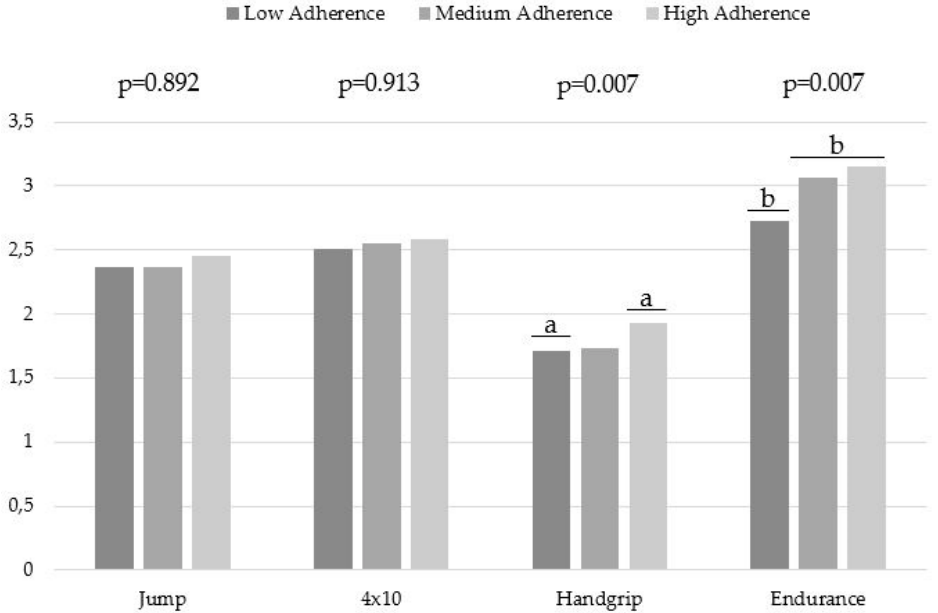
Figure 1. Alpha Fitness physical variables results based on the average levels established by Ortega et al. (2011) according to the different levels of adherence to the MD [39]. Note: Alpha Fitness Levels: 1 (very low), 2 (low), 3 (average), 4 (high), 5 (very high). a statistically significant difference between high adherence with respect to low, b statistically significant differences between medium and high adherence with respect to low.